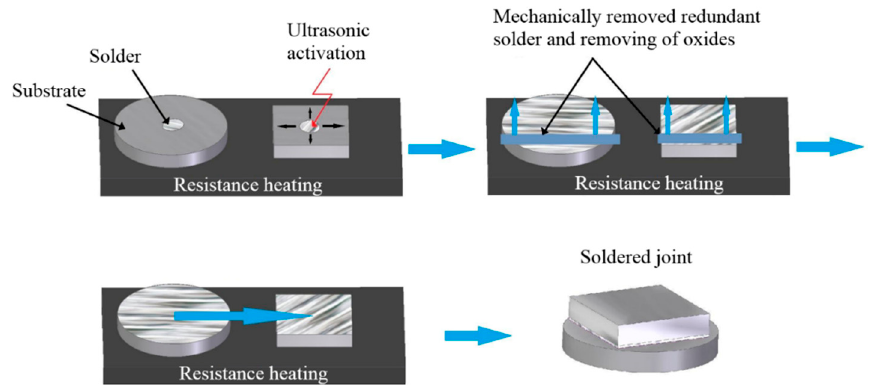
Figure 2. Soldering procedure.